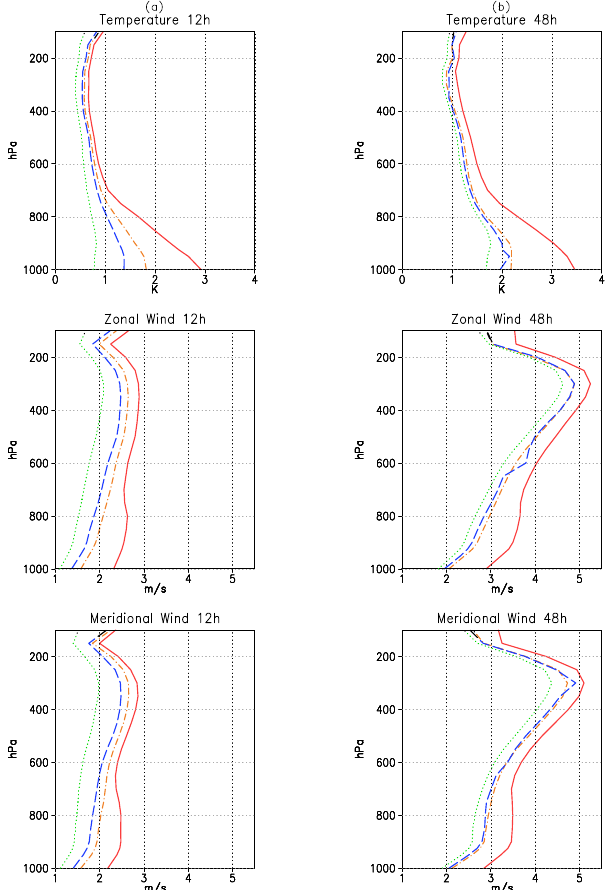
Fig. 5. Vertical profile of the root-mean-square forecast error in the limited area domain at 12-h (a) and 48-h (b) forecast time for the global forecast (red solid) and for the limited area forecasts with coupling Strategies 1 (orange dashes and dots), 2 (blue dashes) and 3 (green